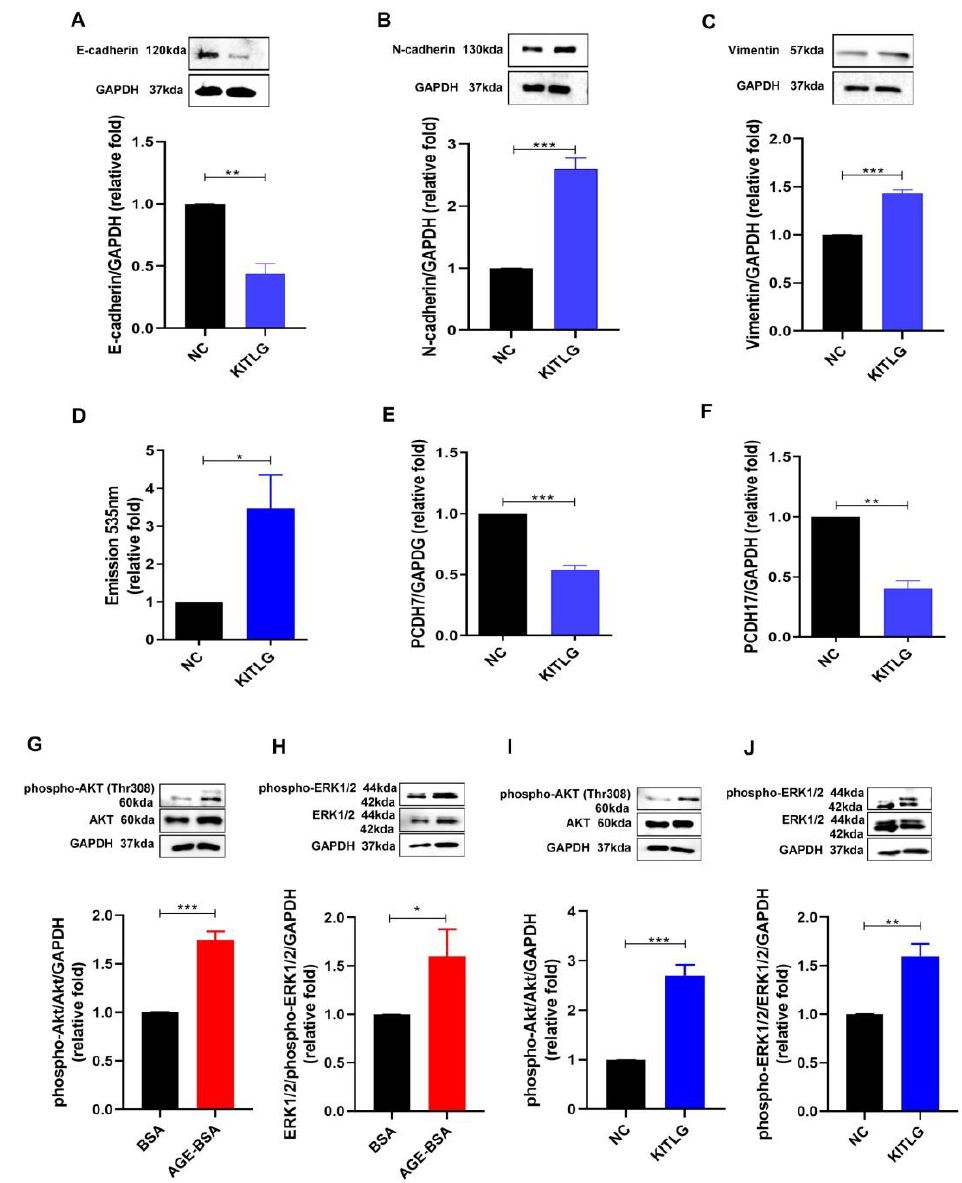
Figure 3. KITLG promoted EndoMT and furthered the increase in permeability of GECs through the AKT/ERK1/2 signaling pathway. EndoMT markers, including E-cadherin, N-cadherin, and vi- mentin levels, were assessed in HGECs treated with BSA (300 μg/ml) or AGE–BSA (300 μg/ml) for 48 h ( n = 3). ( A – C ) After treatment with KITLG (10 ng/ml) for 48 h, EndoMT was examined in HGECs using Western blotting ( n = 3). ( D ) The permeability of HGECs was examined after treatment with normal control (NC) and KITLG (10 ng/ml) for 48 h using FITC – dextran dye ( n = 3). ( E , F ) PCDH7 and PCDH17 mRNA were assessed in HGECs treated with NC and KITLG for 24 h ( n = 3). ( G – J ) The level of phospho-AKT/AKT and phospho-ERK1/2/ERK1/2 protein expression in HGECs treated with BSA, AGE – BSA, NC or KITLG for 6 h were examined using Western blotting. * p < 0.05, ** p < 0.01, *** p < 0 .001 by Student’s t -test. 2.4. Imatinib, as a KITLG Inhibitor, Rescued the Glomerular Endothelial Injury Induced by AGEs According to the positive role of KITLG in AGE-induced glomerular endothelial in- jury in DN, we used imatinib, as a KITLG inhibitor, to further examine whether the sup- pression of KITLG rescued the glomerular endothelial injury induced by AGEs. Firstly, imatinib did not change the viability of HGECs (Figure 4A), indicating that imatinib did